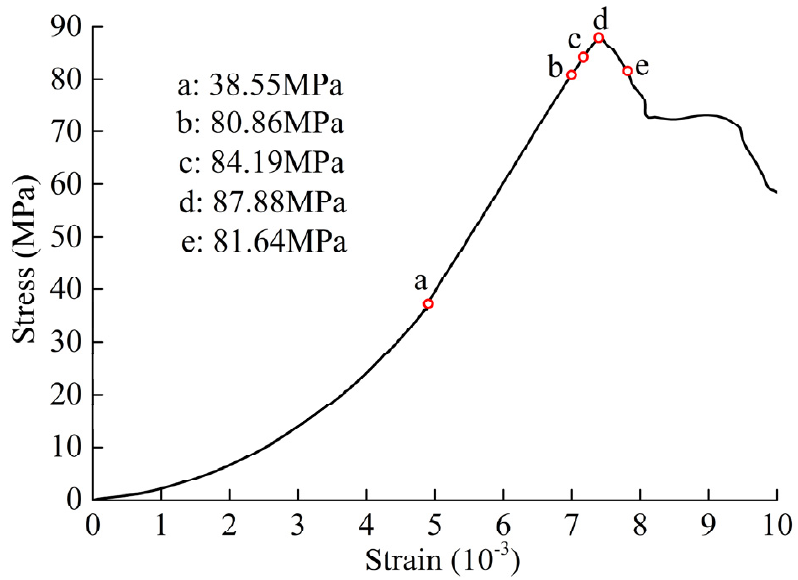
Figure 11. The stress–strain curve and key stress points of specimen D6.